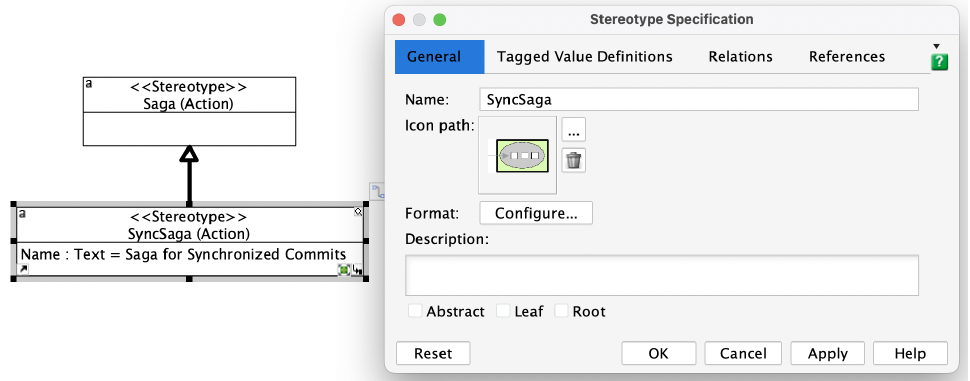
Figure 2. Stereotype Specification window for the << SyncSaga >>